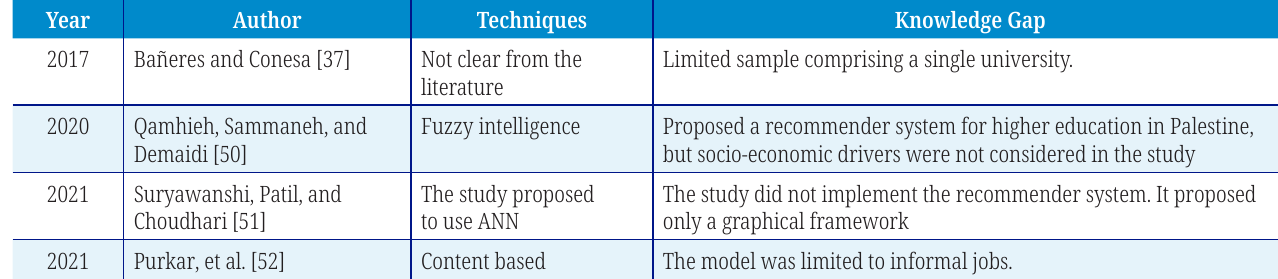
Table 6. Recommender system techniques applied to prescribe graduates’